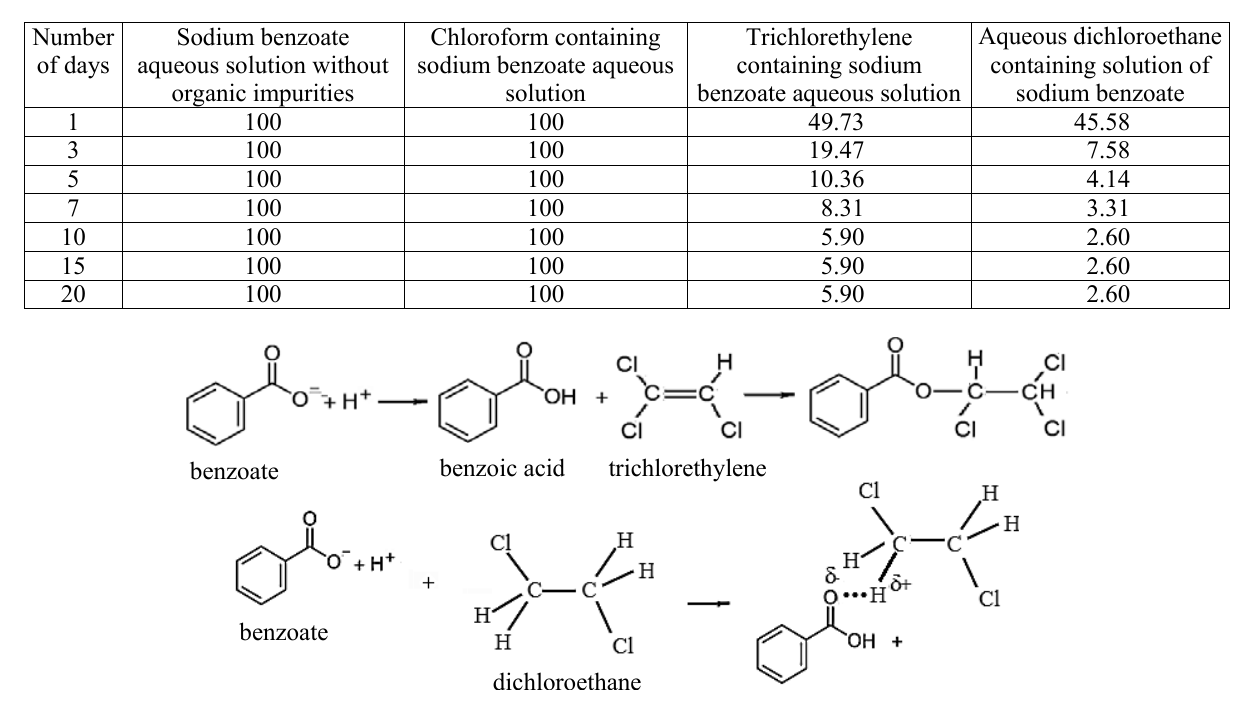
Fig. 1. Chemical interaction of sodium benzoate with the priority contaminants contained in water.